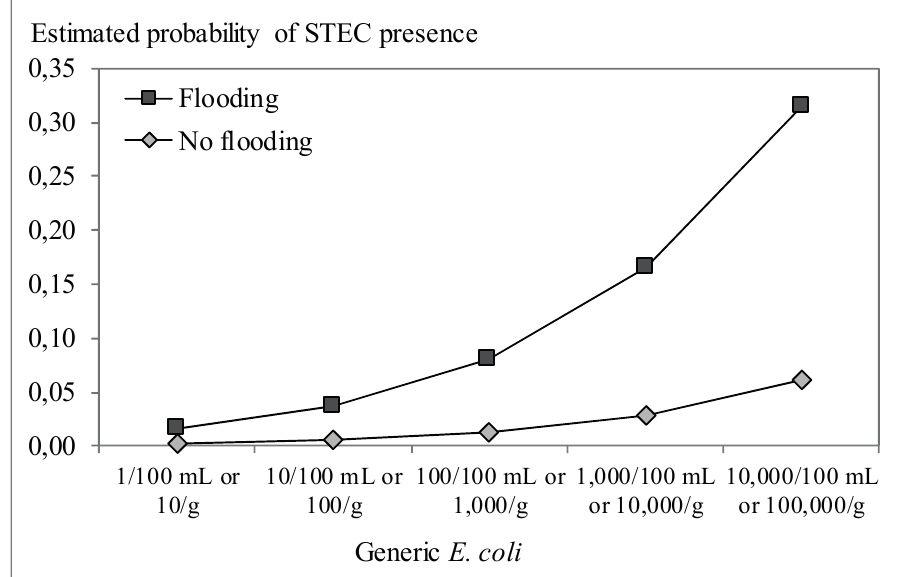
Figure 3. Effect of the generic E. coli concentration and flooding on the estimated risk of Shiga toxin producing E. coli (STEC) presence, isolated by culture, by multiple logistic regression (Table 3).